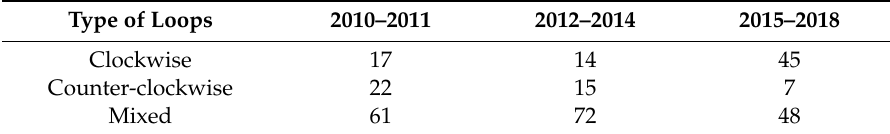
Table 4. Percent of loop types before, during, and after installation of